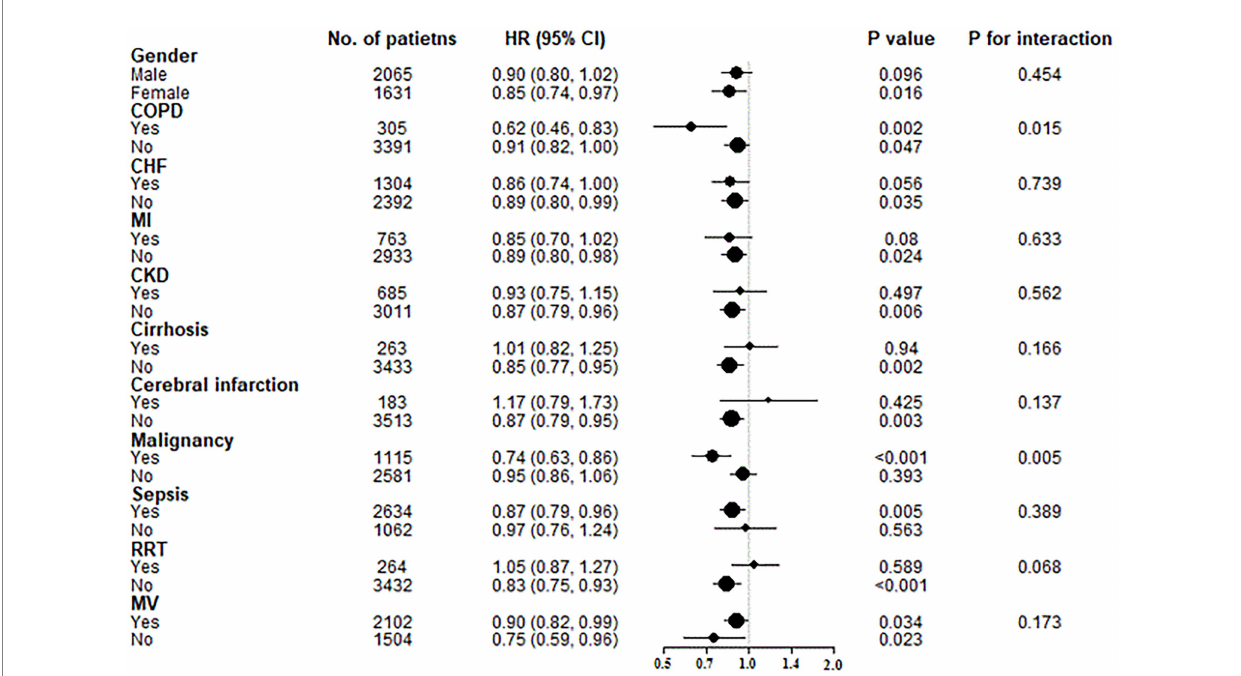
FIGURE 3 Subgroup analyses of the associations between GNRI levels and hospital mortality. GNRI was standardized to a Z -score. Above models were adjusted for variables in model 3. In each case, the model was not adjusted for stratification variable. COPD, chronic obstructive pulmonary disease; CHF, chronic heart failure; HI, myocardial infarction; CKD, chornic kidney disease; RRT, renal replacement therapy; MV, mechanical ventilation.